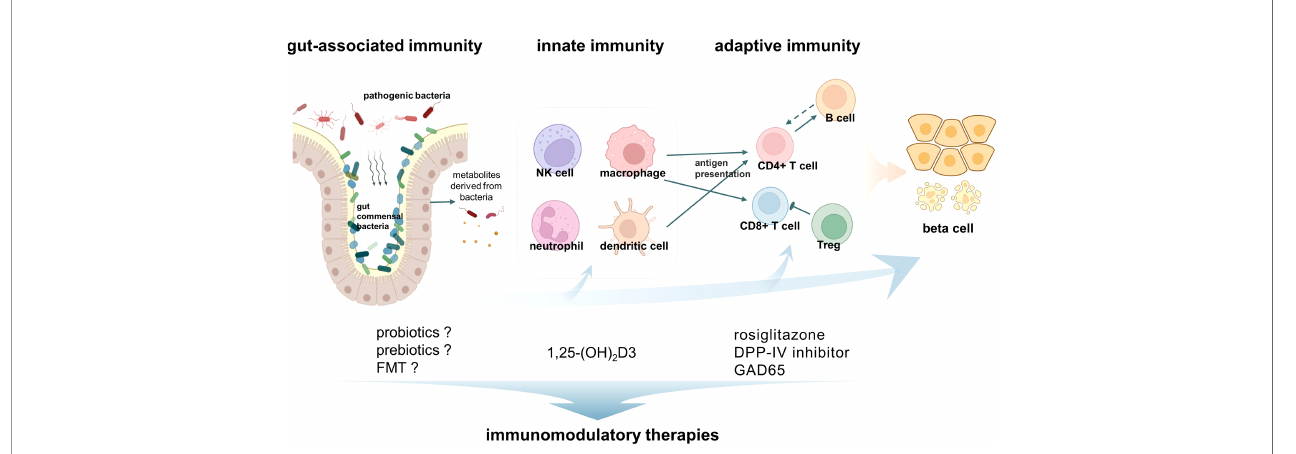
FIGURE 1 | Immunity activates latent autoimmune diabetes in adults (LADA) and immunomodulatory therapies. The pathogenesis of LADA is the result of the interaction of innate immunity, adaptive immunity, and gut-associated immunity. Macrophages and CD8 + T cells are the most abundant immune cells in fi ltrating in the insulitis of LADA patients. In addition, other immune cells such as NK cells, neutrophils, CD4 + T cells, and B cells were also found to be involved in the development of LADA. A variety of corresponding immunomodulatory therapies have been